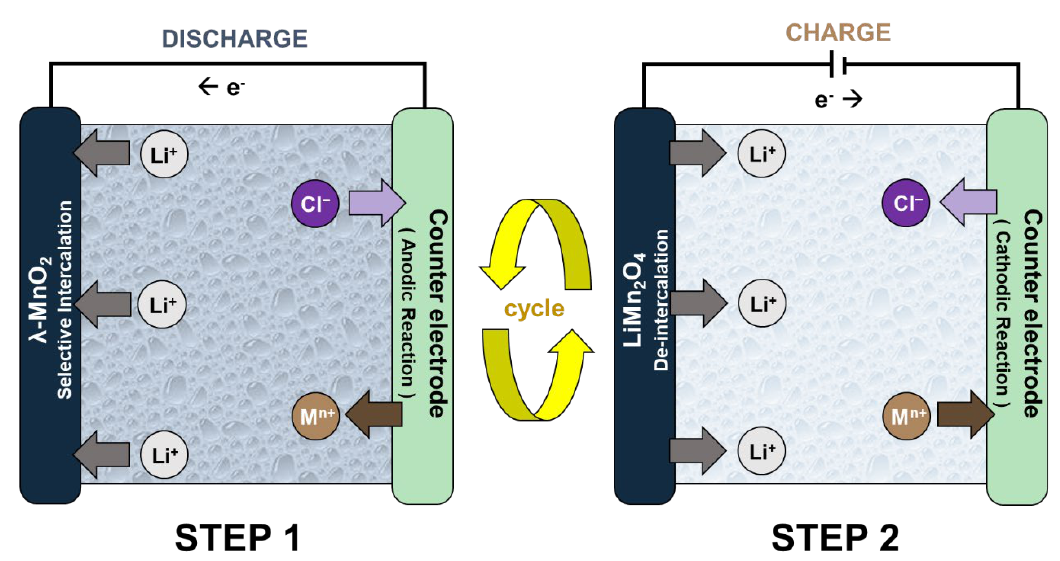
Figure 1. The operational principle of the electrochemical lithium recovery (ELR) systems.